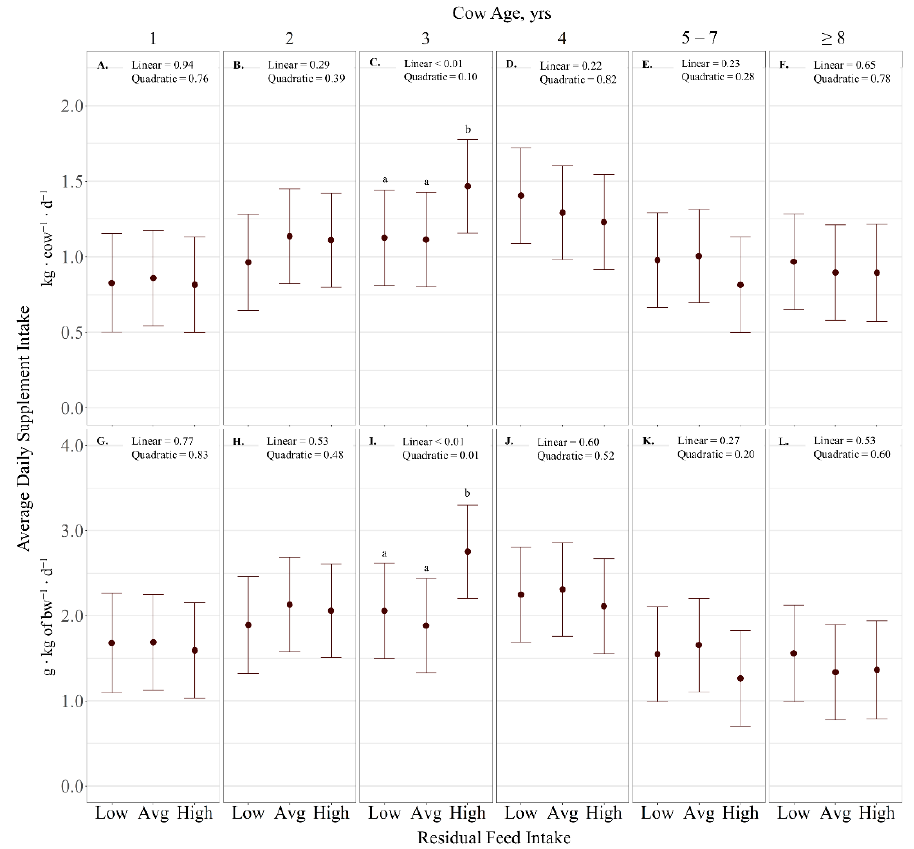
Figure 2. Influence of RFI × cow age ( p < 0.01) on average daily supplement intake (ex- pressed as g ∙ kg − 1 of BW ∙ d − 1 ( A – F ), as well as kg ∙ cow − 1 ∙ d − 1 ( G – L ) ± SE) by cattle graz- ing dormant mixed-grass prairie in 2018/2019 and 2019/2020 at the Northern Agriculture Research Center’s Thackeray Ranch, Havre, MT, USA. Means lacking common letters (a, b) differ ( p < 0.05).